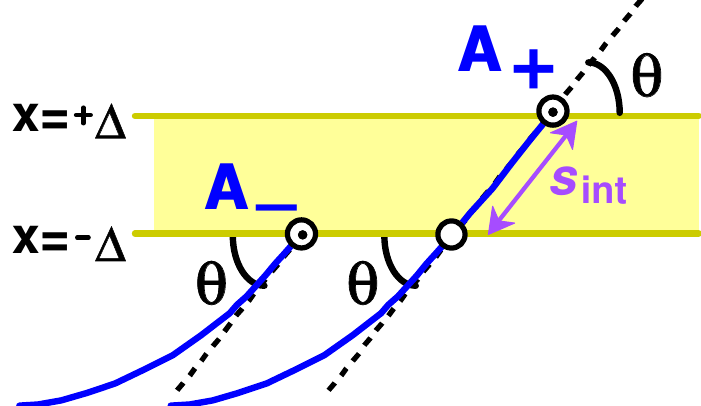
Figure 2. Two chains with the same orientation at x = − ∆ defined by the angle θ > 0. One chain ends at point A − just below the membrane. The second chain ends at point A + slightly above the membrane intersecting it with the end segment of length s int